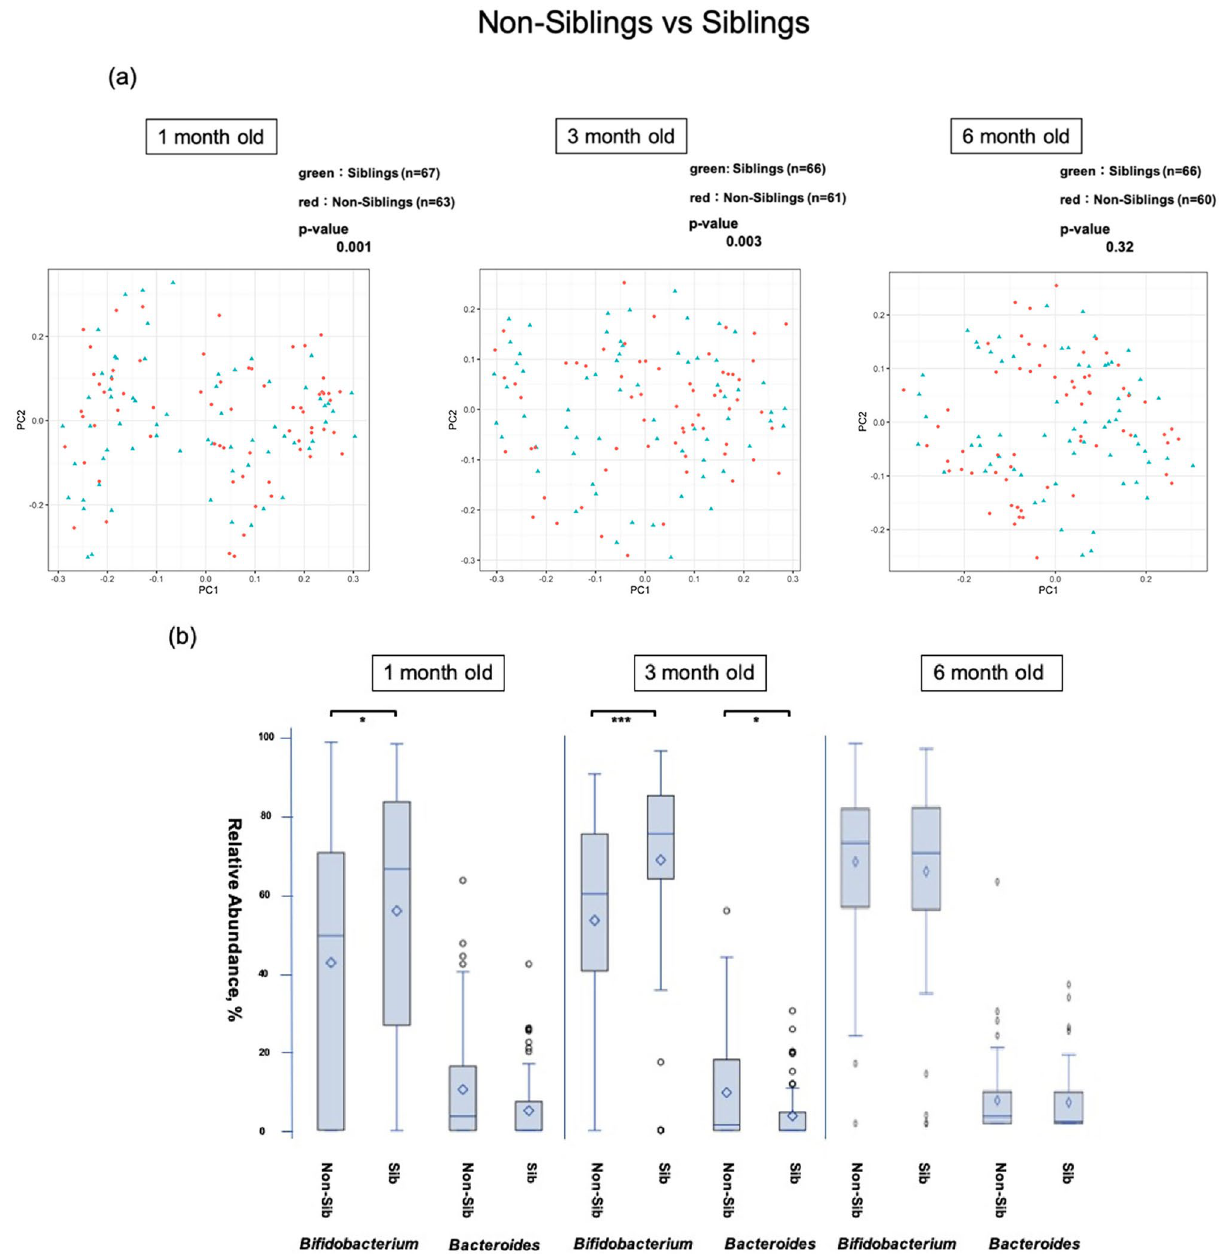
Figure 6. Comparison of the β diversity and occupancy of the top two bacteria species between the infants with siblings and those without siblings ( a ) Comparison of β diversity of the intestinal microbiome between infants with and without siblings. ( b ) Bifidobacteria and Bacteroides occupancies between infants with siblings (Sib) and without siblings (Non-Sib), shown as box-whisker plots at each age. The Sib and non-Sib groups included 67 and 63 infants at 1 month (130 in total), 61 and 66 infants at 3 months (127 in total), and 66 and 60 infants at 6 months (126 in total). The significance level was set at 5%. * p < 0.05, *** p < 0.001 using Mann–Whitney U-test. This figure was generated using SAS version 9.4 (https